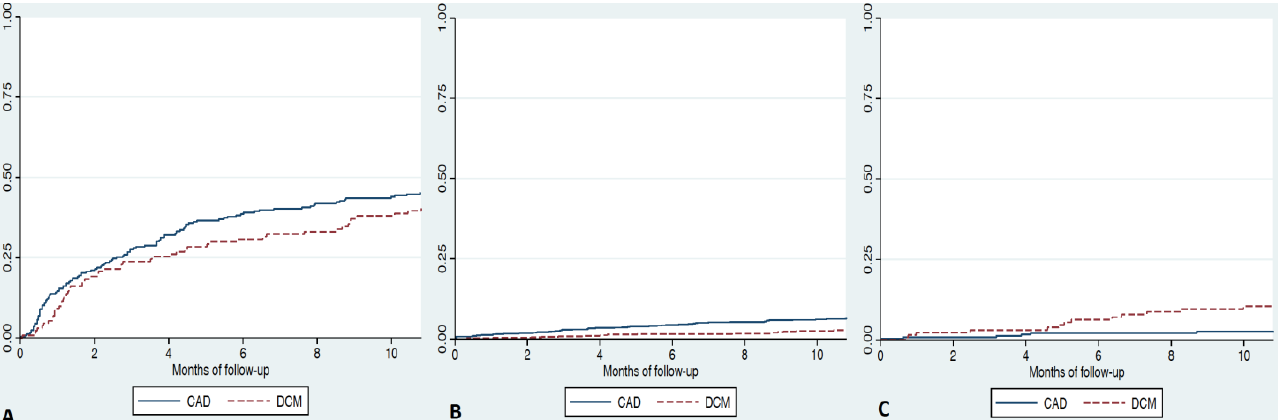
Table 4. Independent predictors of 12-month mortality and readmissions by Cox regression analysis.